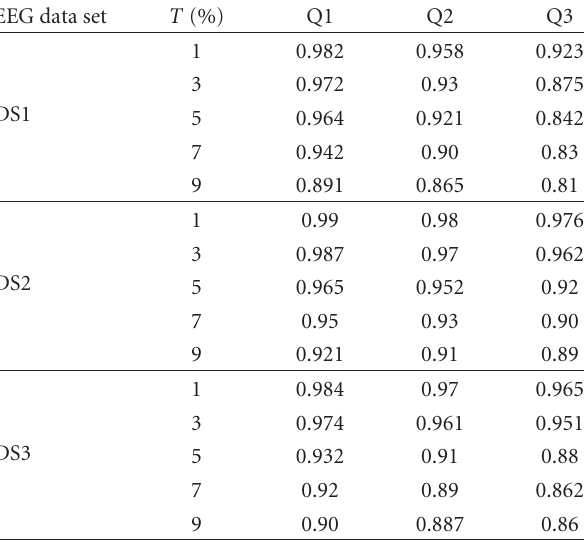
Table 6: Estimation of CC using di ff erent two-stage